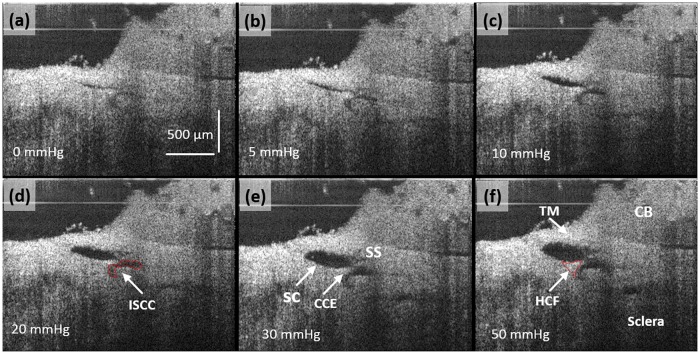
(a)–(f) OCT cross-sectional images under the steady state pressures of 0, 5, 10, 20, 30 and 50 mmHg, respectively.OCT imaging resolution is high enough to permit quantification of the configuration changes in Schlemm’s canal, collector channel entrances and intrascleral collector channels and their relationship under steady state pressure conditions. The ISCC in (d) and the HCF in (f) are outlined in red. Trabecular Meshwork (TM), Hinged Collagen Flap (HCF), Ciliary Body (CB).